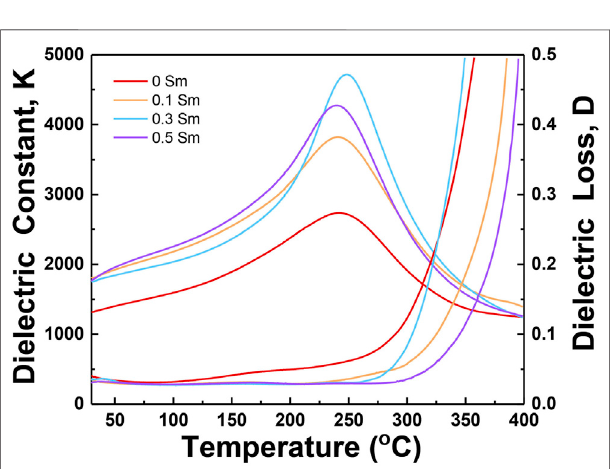
FIGURE 3 | Temperature-dependent dielectric constant and dielectric loss of un-doped (Quan et al., 2018) and Sm 3+ -modi fi ed KNLN-BZ-BNT ceramics.